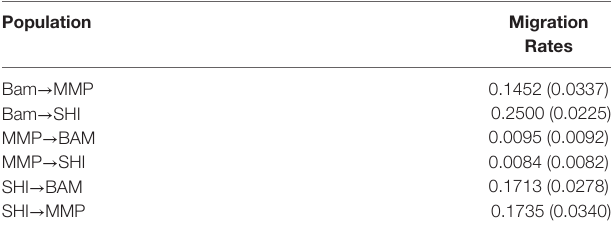
TABLE 5 | Posterior means of contemporary migration rates estimated by BAYESASS (values in brackets are standard deviations, and mean values more than 0.1 are considered